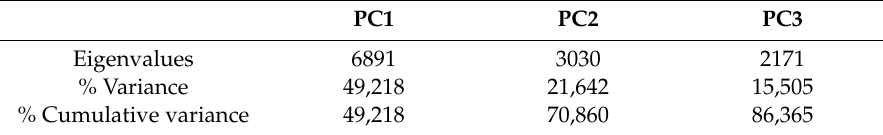
Table 9. Variance in principal components and cumulative contribution to total variation.